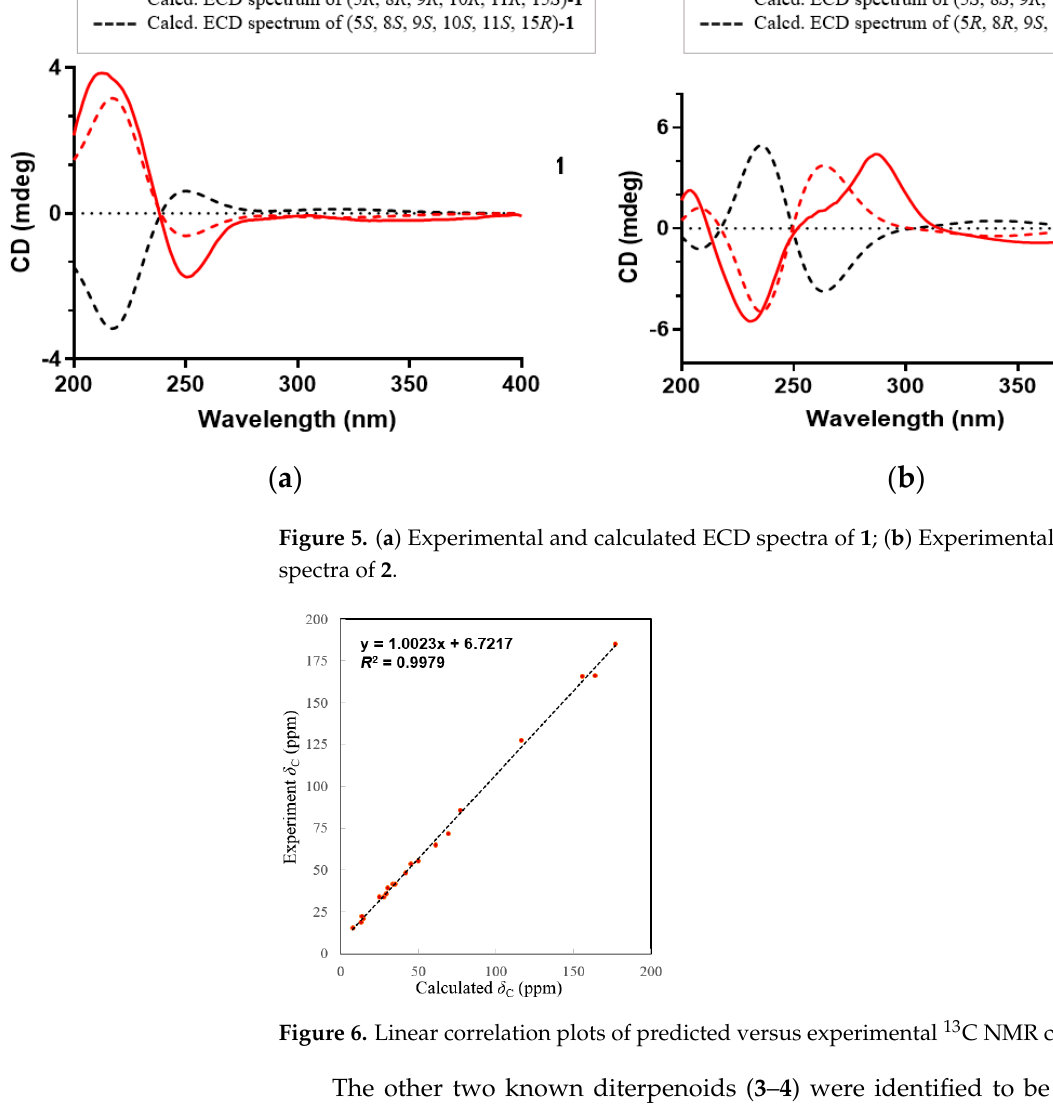
Figure 6. Linear correlation plots of predicted versus experimental 13 C NMR chemical shifts.